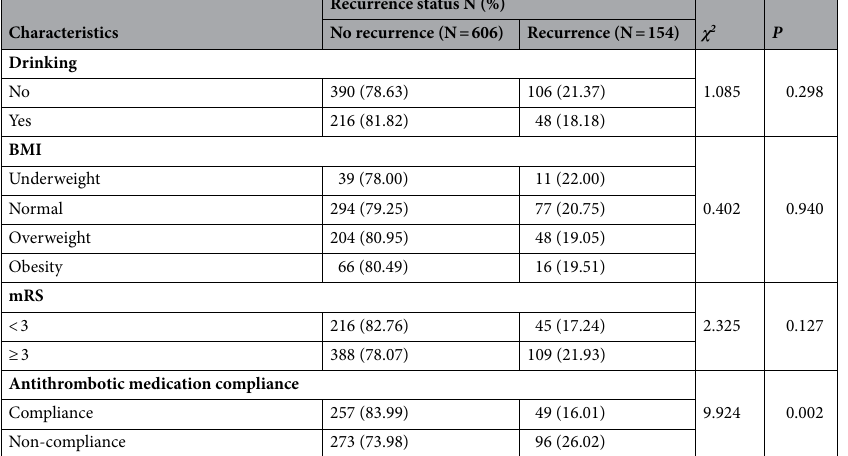
Table 1. Recurrence of survivors with different characteristics.